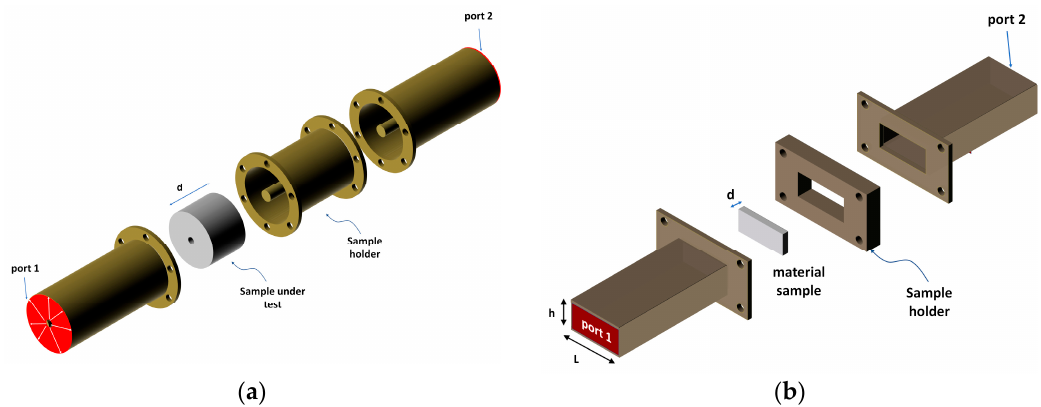
Figure 2. Transmitting/reflecting devices with the material sample to be characterised: ( a ) coaxial cable; ( b ) waveguide.